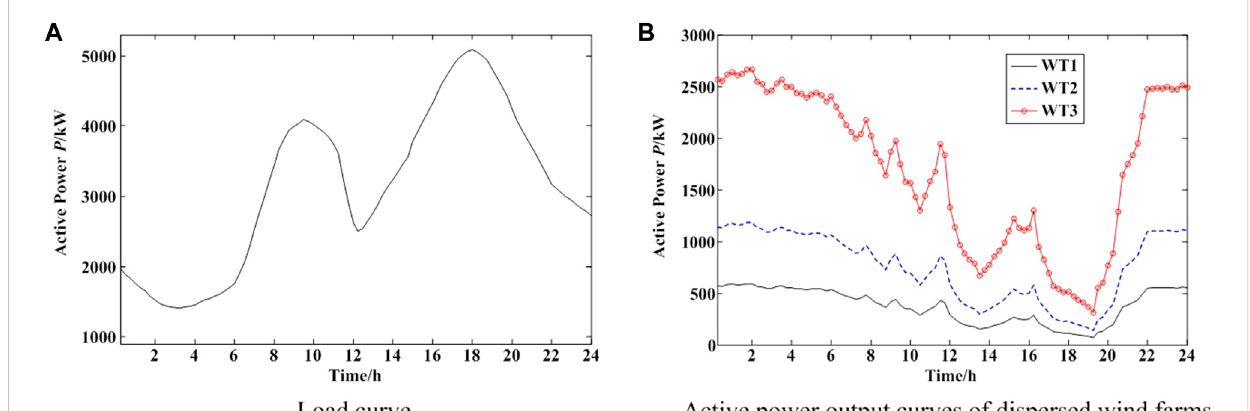
FIGURE 5 Diagram of case data in a typical day.